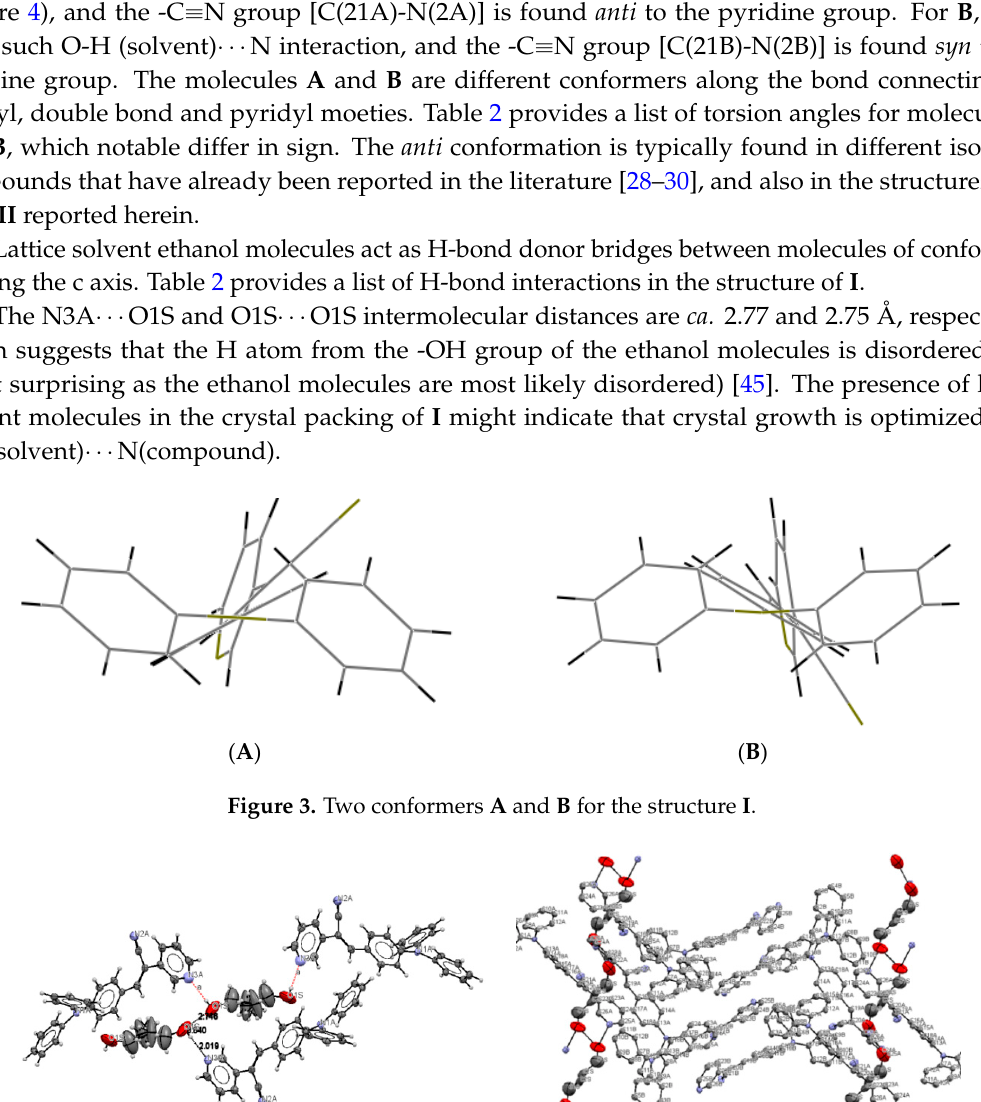
Figure 2. Displacement ellipsoid plots (50% probability level) of I . The two crystallographically independent molecules A and B are shown separately.